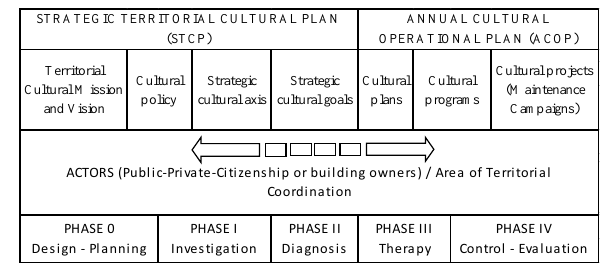
Table 1: Construction process of the territorial governance of heritage. Source: Amaya 2017